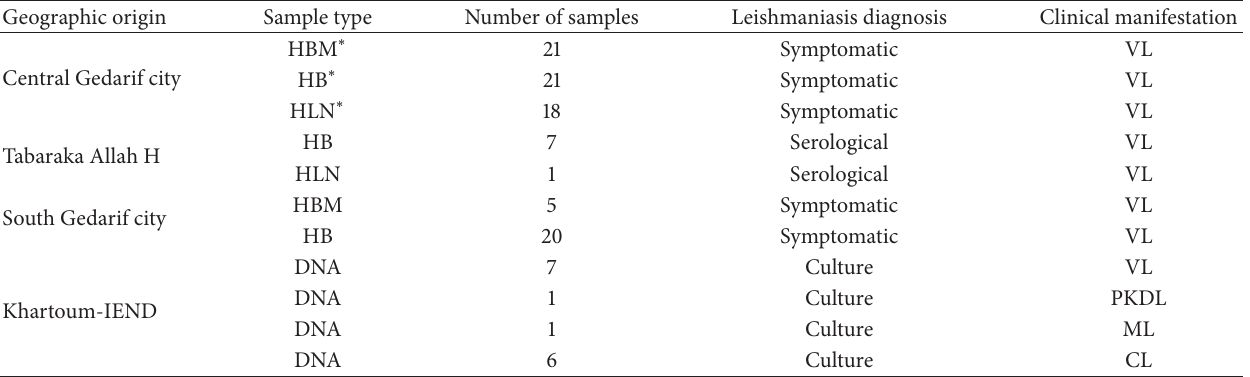
Table 1: Provenance, numbers, and types of samples collected included in the